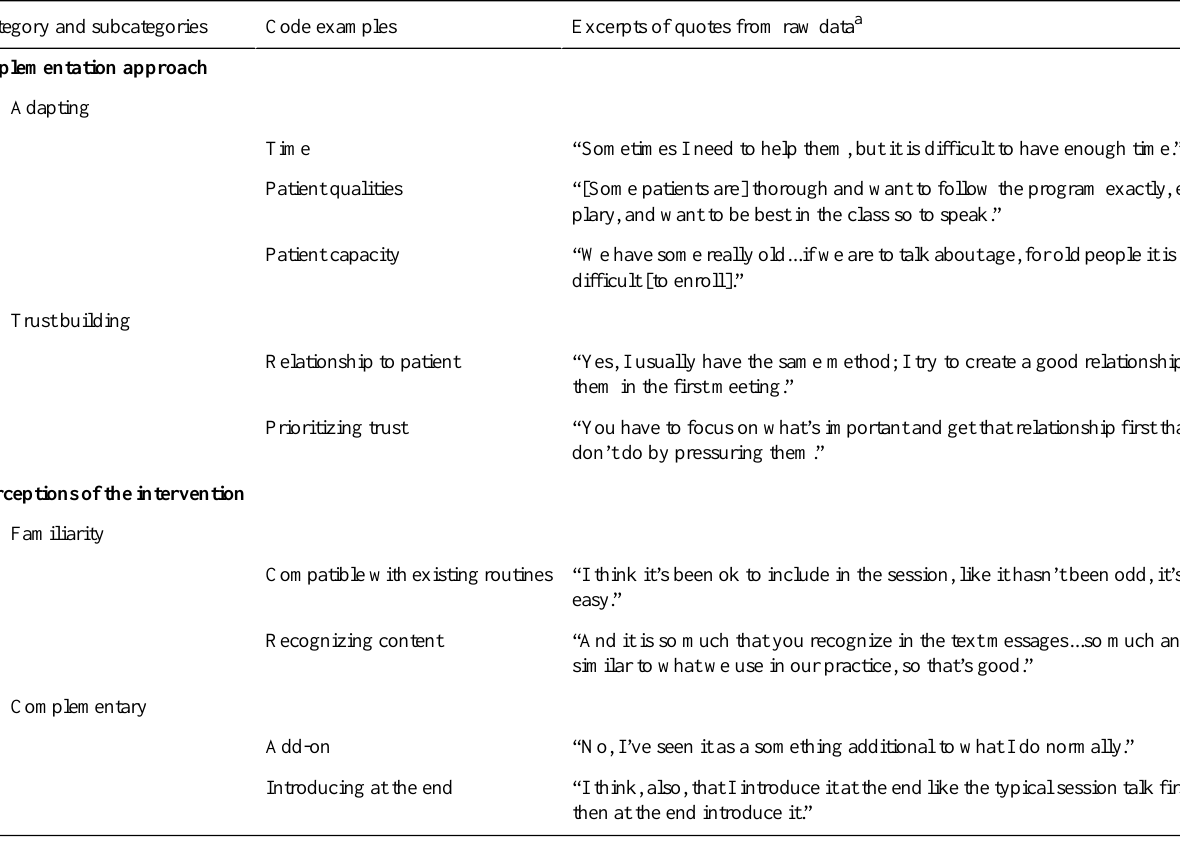
Table 1. List of categories, subcategories, and code examples for specialist data.